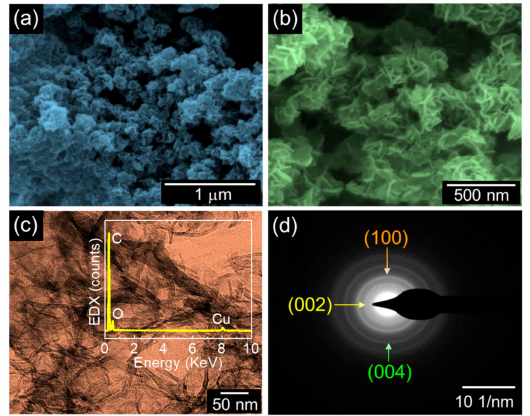
Figure 3. Morphological, microstructural, and compositional properties of the IMP-GC nanoflakes: ( a ) field-emission (FE)-SEM image; ( b ) zoomed-in FE-SEM image; ( c ) high-resolution TEM image with the in situ energy-dispersive X-ray (EDX) spectrum (inset); ( d ) selective-area electron di ff raction